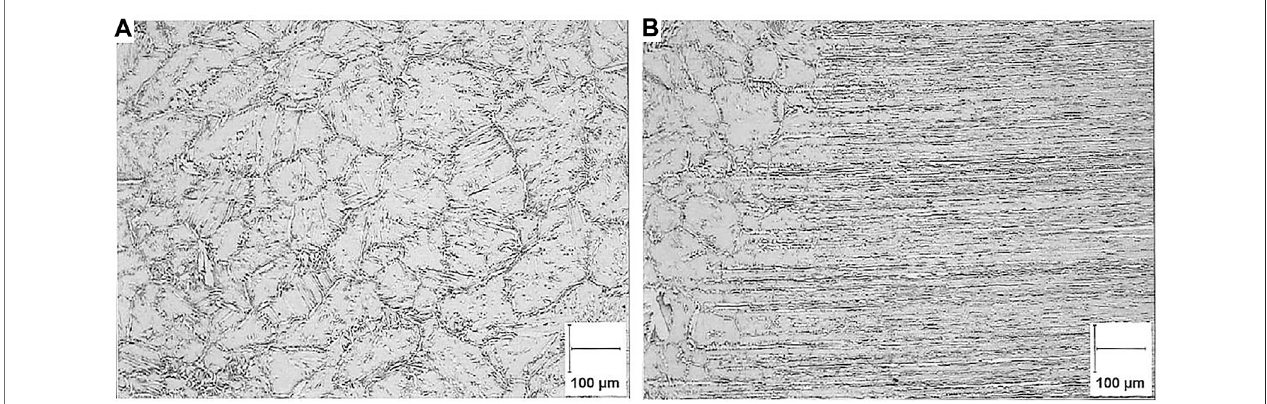
FIGURE 2 | Microstructure of welded UNS 32750 SDSS 4 sample (A) weld and (B) HAZ.